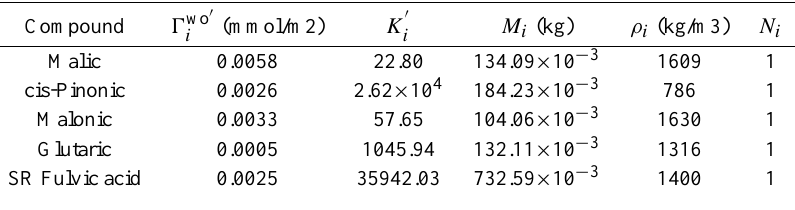
Table 1. Compounds and properties used within a multicomponent example. Data derived from Topping et al. (2007) and Booth et al. (2009).